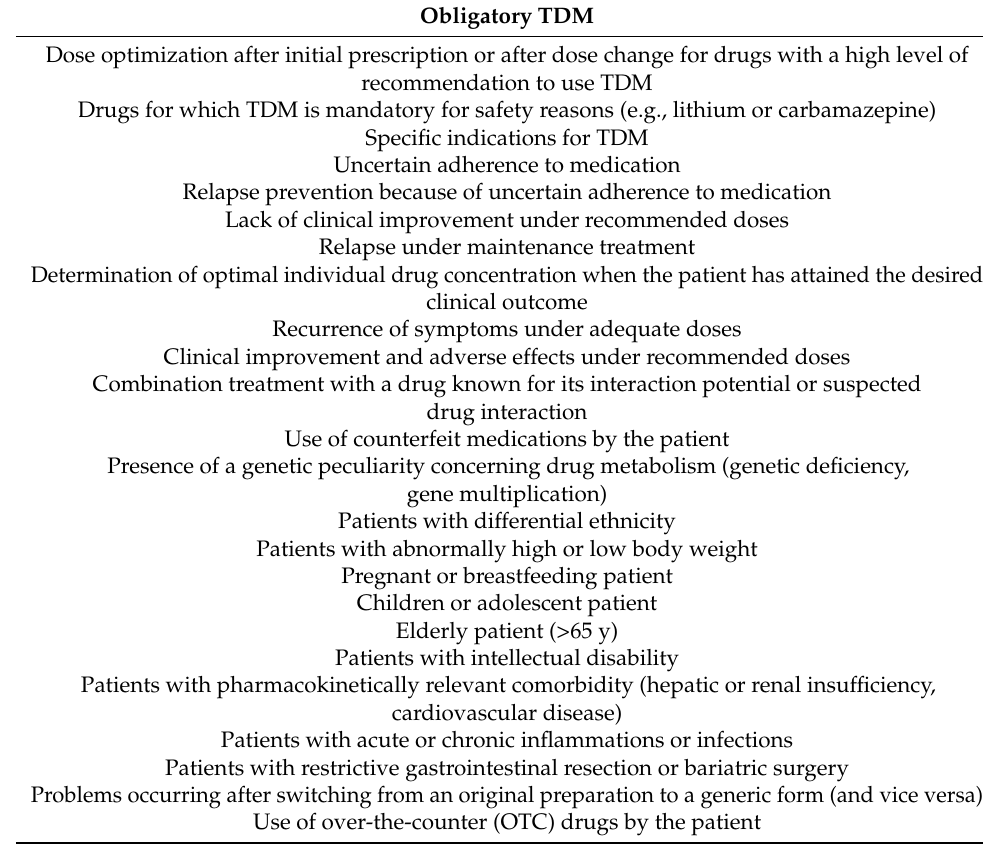
Table 1. TDM recommendation in neuropsychopharmacological